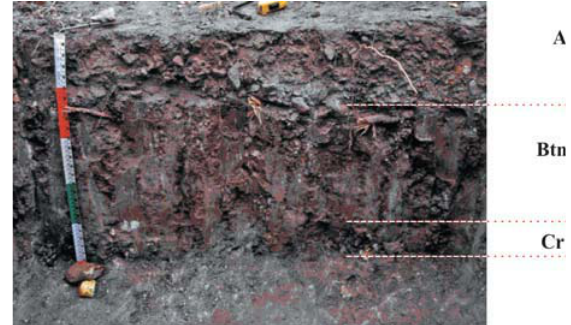
Figura 2. Perfil MJ-1 - Planossolo Nátrico órtico típico, em ambiente moderadamente degradado de Jataúba,